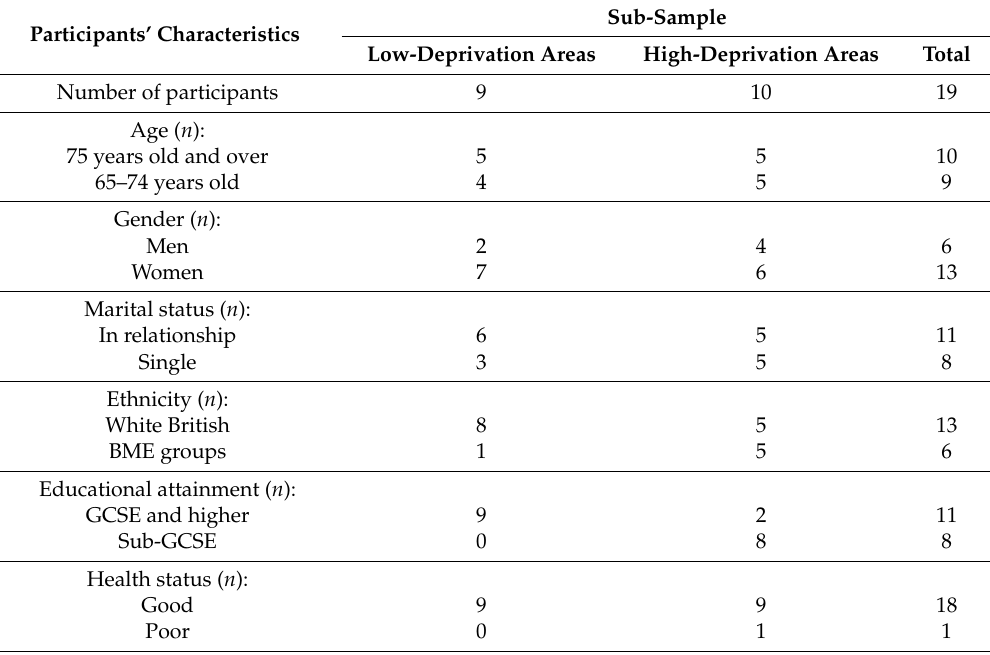
Table 4. Detailed information about sub-sample (participants for walking